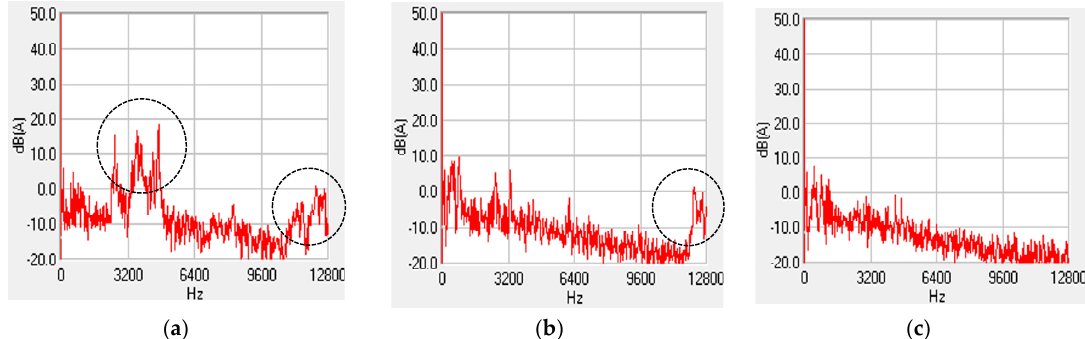
Figure 21. Results of the acoustic noise measurements at 30 rpm: ( a ) Conventional method; ( b ) proposed method; ( c ) current sensor.